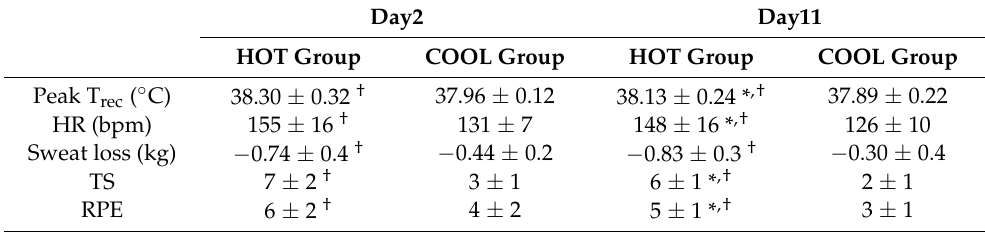
Values are mean ± SD. *: Significant difference versus Day2. † : Significant difference versus COOL. Variables in table are peak values during 60 min of training session on Day2 and Day11. Trec: rectal temperature. HR: heart rate. TS: thermal sensation. RPE: rate of perceived exertion.